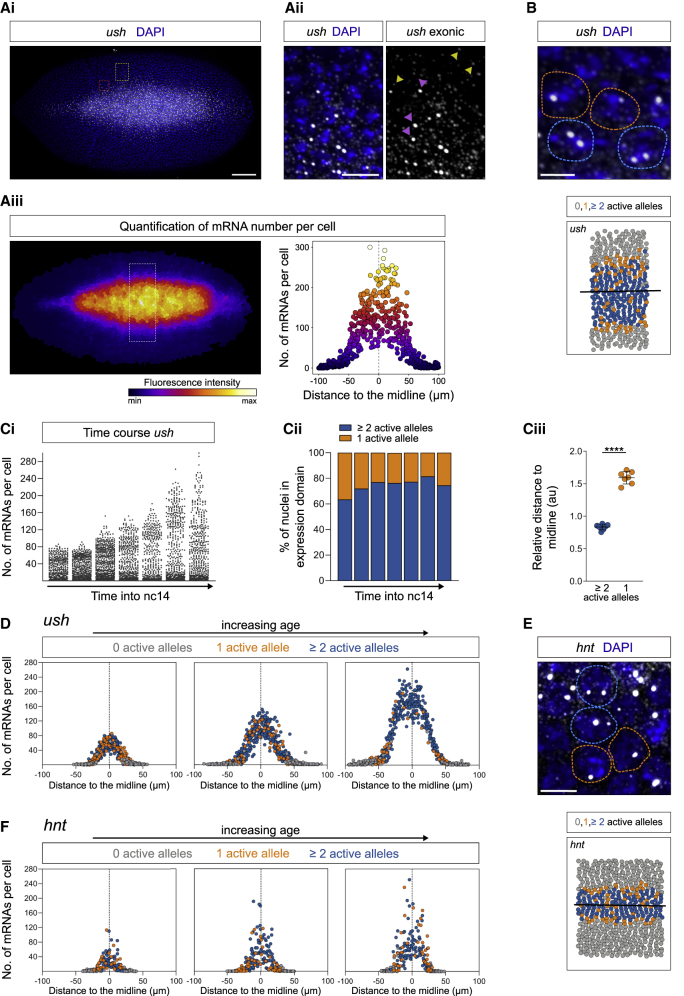
BMP Target Genes Show Stochastic Transcription and Graded mRNA Outputs(A) Fixed Drosophila embryo stained with exonic ush smFISH probes (gray) and DAPI (blue) (Ai). Inset outlined by the red box shown in (B) and by the yellow box in (Aii) highlighting nascent transcription sites (pink arrowheads) and single mRNAs (yellow arrowheads). Image false colored by the combined fluorescence of individual mRNAs per cell (Aiii). Graph shows the quantification of the number of mRNAs per cell. Each point represents a nucleus from the domain outlined by the white rectangle in (Aiii).(B) Enlarged region from (Ai) showing nuclei with one (orange outline) or two alleles (blue outline) actively transcribing ush. Schematic shows the expression region outlined in (Aiii) with nuclei false colored according to the number of active transcription foci. A line of best fit shows the middle of the expression domain.(C) Number of ush mRNAs per cell in embryos of increasing age in nc14 (Ci), the percentage of nuclei with one (orange) or two (blue) active alleles in each time course embryo (Cii) and their median distance to the middle of the expression domain (Ciii) (n = 7 embryos).(D) Number of ush mRNAs per cell plotted according to the distance from the dorsal midline, at three time points (data from embryos 1, 4, and 6 in Ci). Embryos are ordered by increasing age and points are colored based on the number of active transcription foci.(E) As in (B) showing an enlarged region of an smFISH image indicating nuclei transcribing one (orange outline) or two hnt alleles (blue outline). Full image in Figure S5A.(F) as in (D) showing hnt time course data.Scale bar, 50 μm (Ai), 10 μm (Aii), or 5 μm (B and E). ∗∗∗∗p < 0.0001. Mean ± SD (Ciii). Student’s t test (Ciii). See also Figure S5.